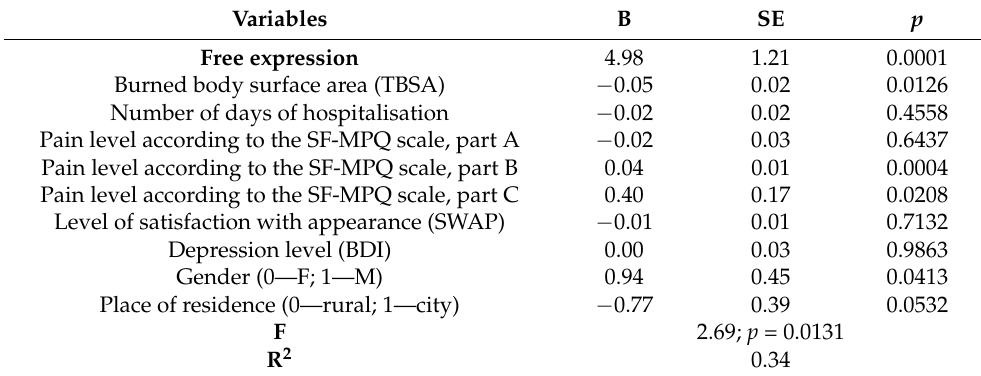
Table 3. Factors influencing daily functioning (ADL scale)—multiple regression results. Variables B SE p Free expression 4.98 1.21 0.0001 Burned body surface area (TBSA) − 0.05 0.02 0.0126 Number of days of hospitalisation − 0.02 0.02 0.4558 Pain level according to the SF-MPQ scale, part A − 0.02 0.03 0.6437 Pain level according to the SF-MPQ scale, part B 0.04 0.01 0.0004 Pain level according to the SF-MPQ scale, part C 0.40 0.17 0.0208 Level of satisfaction with appearance (SWAP) − 0.01 0.01 0.7132 Depression level (BDI) 0.00 0.03 0.9863 Gender (0—F; 1—M) 0.94 0.45 0.0413 Place of residence (0—rural; 1—city) − 0.77 0.39 0.0532 F 2.69; p = 0.0131 R 2 0.34